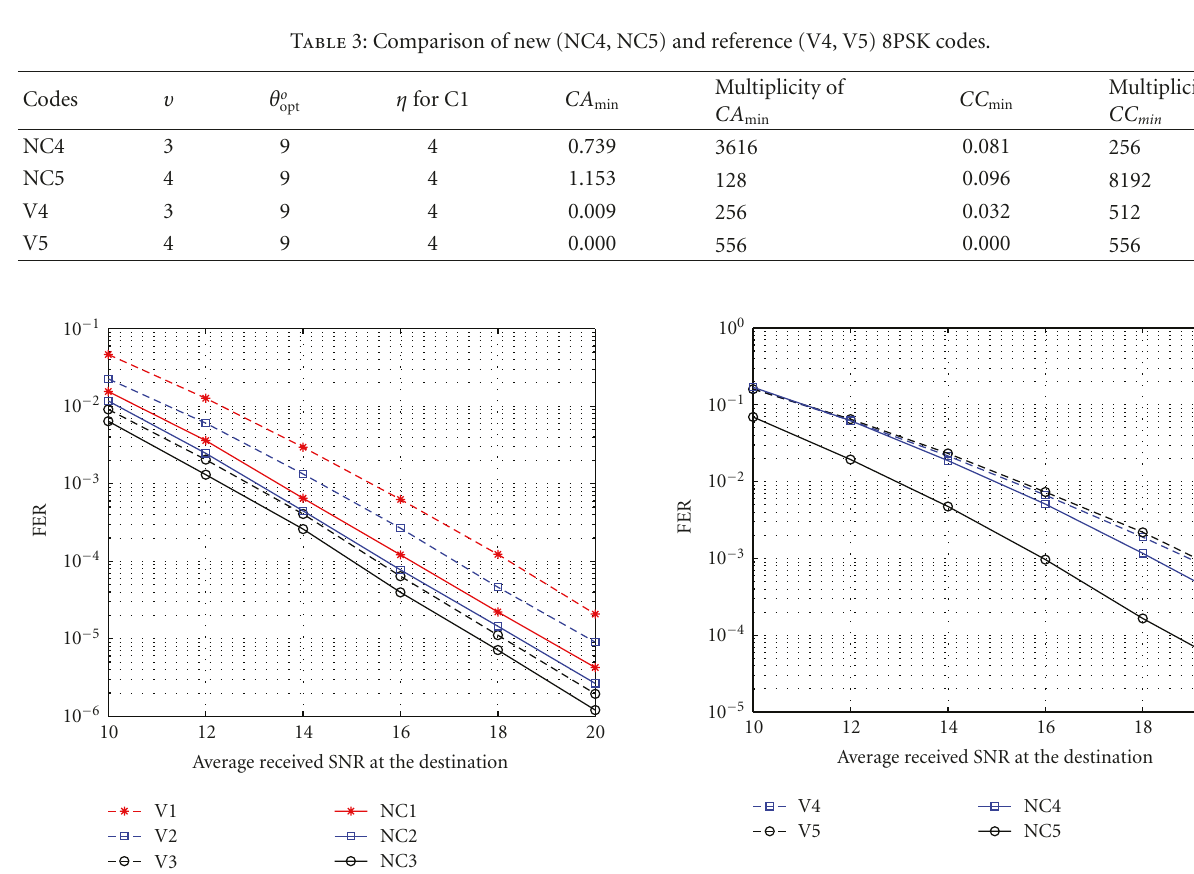
Figure 6: FER performances of QPSK codes for cooperation case C1.